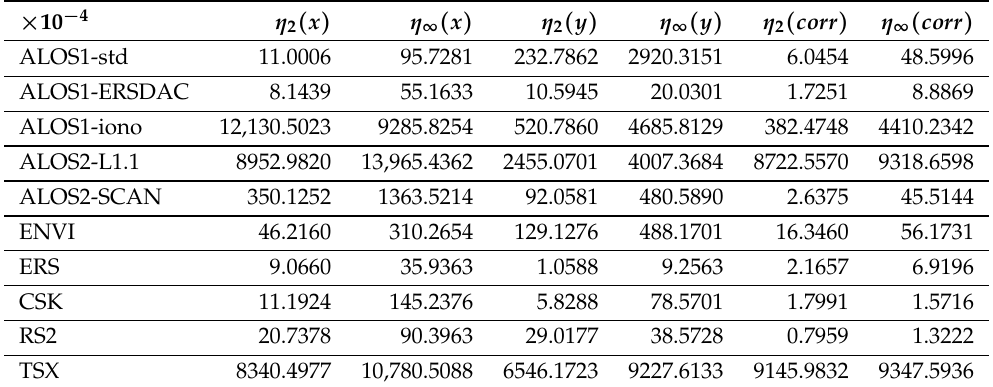
Table 3. Accuracy of xcorr-cl . Vectorial relative error × 10 − 4 for x and y offsets, and correlation with both two-norm and